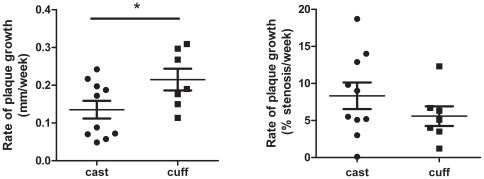
Plaques Progress More Rapidly in Casted vs Cuffed Animals.The rate of plaque growth was determined by performing individual linear regression analysis of plaque length or stenosis over time for each animal. The slopes (rates) were compared by unpaired t-test. (a) Rate of plaque growth in length (b) Rate of plaque growth in terms of stenosis. Data are mean±SEM, n = 7 cuffs, 10 casts “*” indicates p<0.05. (See Fig. S2 for source data.)